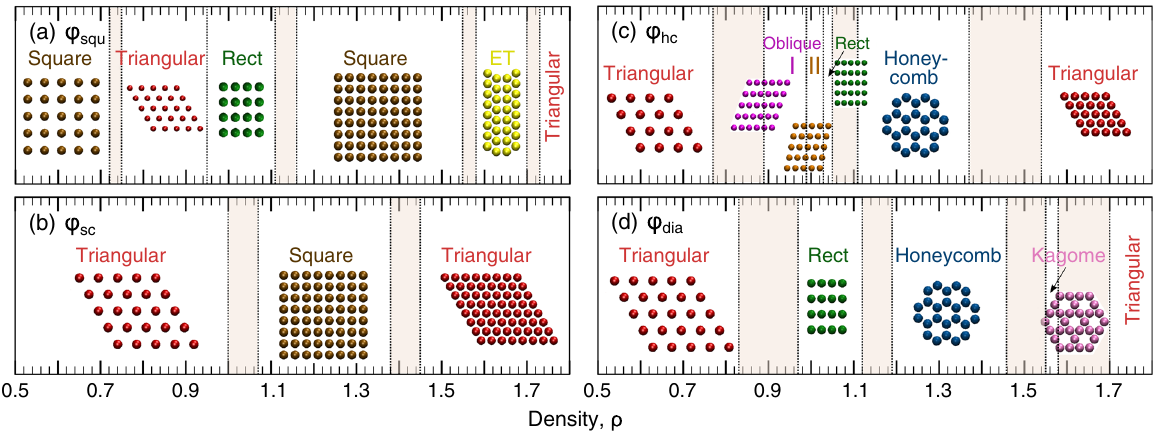
FIG. 2. 2D ground-state lattices as a function of density for (a) φ between the neighboring lattices on the phase diagram. ET represents the elongated-triangle Archimedean tiling. Parameters for the oblique and rectangular (Rect) lattices are provided in Table S2 in the Supplemental Material